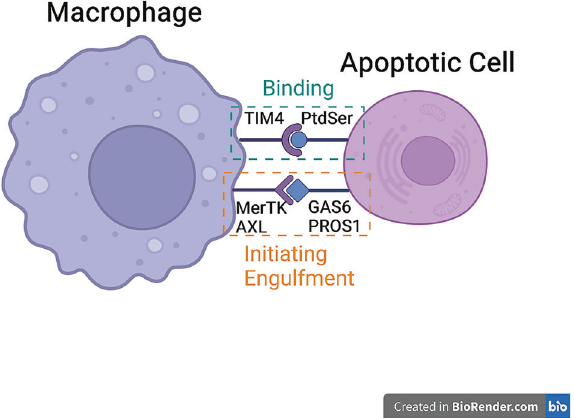
Fig. 2 Interaction between macrophage and apoptotic cell mediates phagocytosis and efferocytosis of macrophages. As PtdSer is fl ipped onto the surface of dying cells, TIM4 on macrophages can identify and bind to PtdSer tightly. However, the binding cannot initiate engulfment. To engulf dying cells, TAM family, mainly MerTK and AXL, is required to bind with GAS6 or PROS1 in order to initiate rapid engulfment activity.